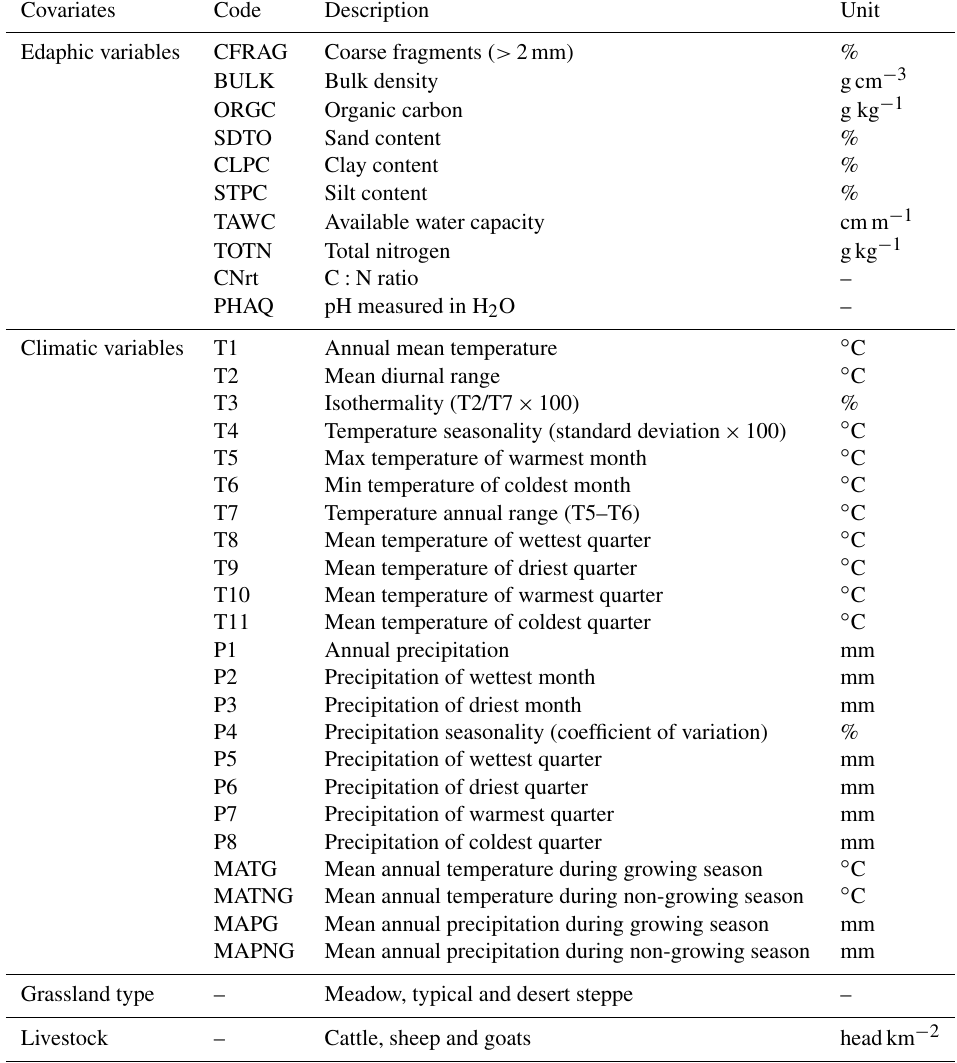
Table 1. The environmental covariates used in this